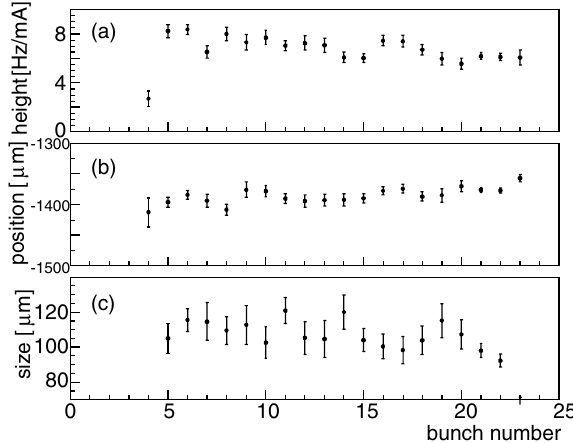
FIG. 7. Bunch dependence of the 20-bunch beam (horizontal measurement). (a) The peak height; (b) the horizontal peak ; (c) the peak width (cid:11) (cid:5) x (cid:6) meas . position x p